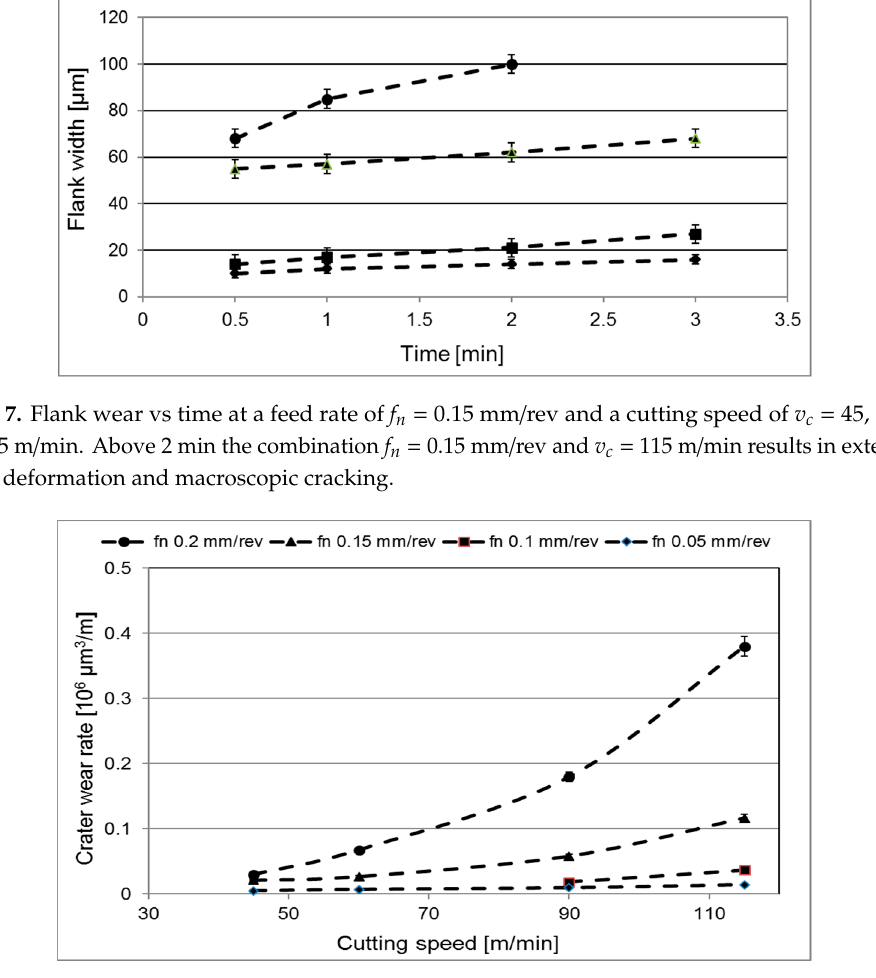
Figure 8. Calculated crater wear rate vs cutting speed v c for the di ff erent feed rates evaluated, f n = 0.05, 0.10, 0.15, and 0.20 mm/rev.